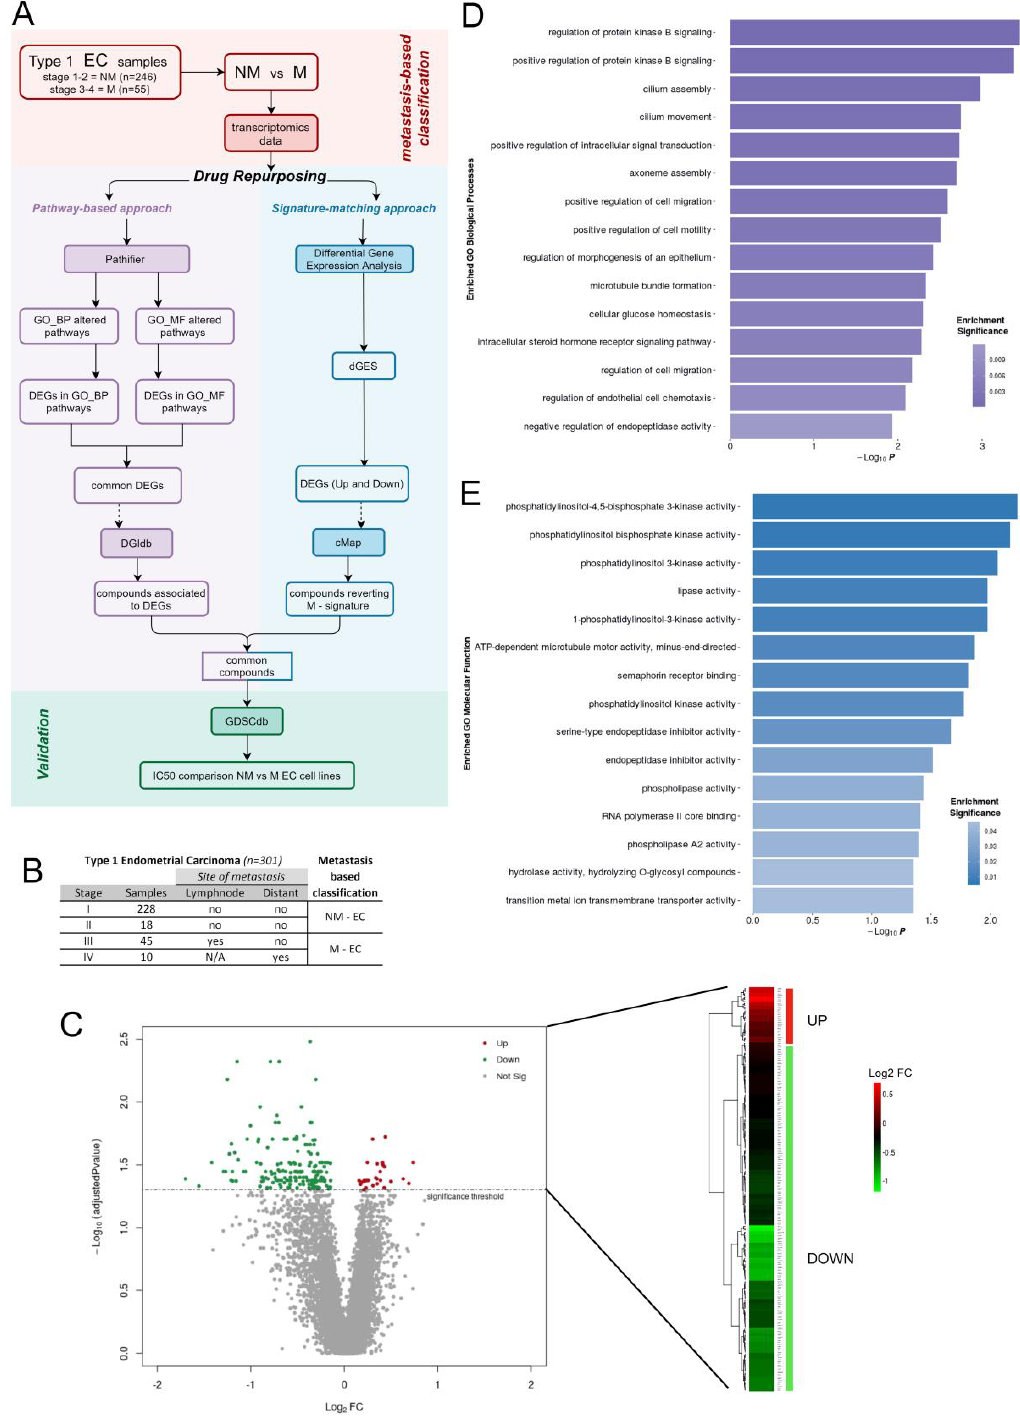
Figure 1. Comparison of metastatic and non-metastatic EC transcriptomic profiles: ( A ) Computational framework overview of the integrative drug repurposing pipeline. ( B ) Table summarizing metastasis-based re-classification of Type 1 EC samples. ( C ) Volcano plot and a heat map showing significantly UP and DOWN-regulated genes constituting dGES (FDR < 0.05). ( D , E ) Functional enrichment analysis of dGES, Gene Ontology-Biological Processes (GO_BO), and Gene Ontology-Molecular Functions, respectively.